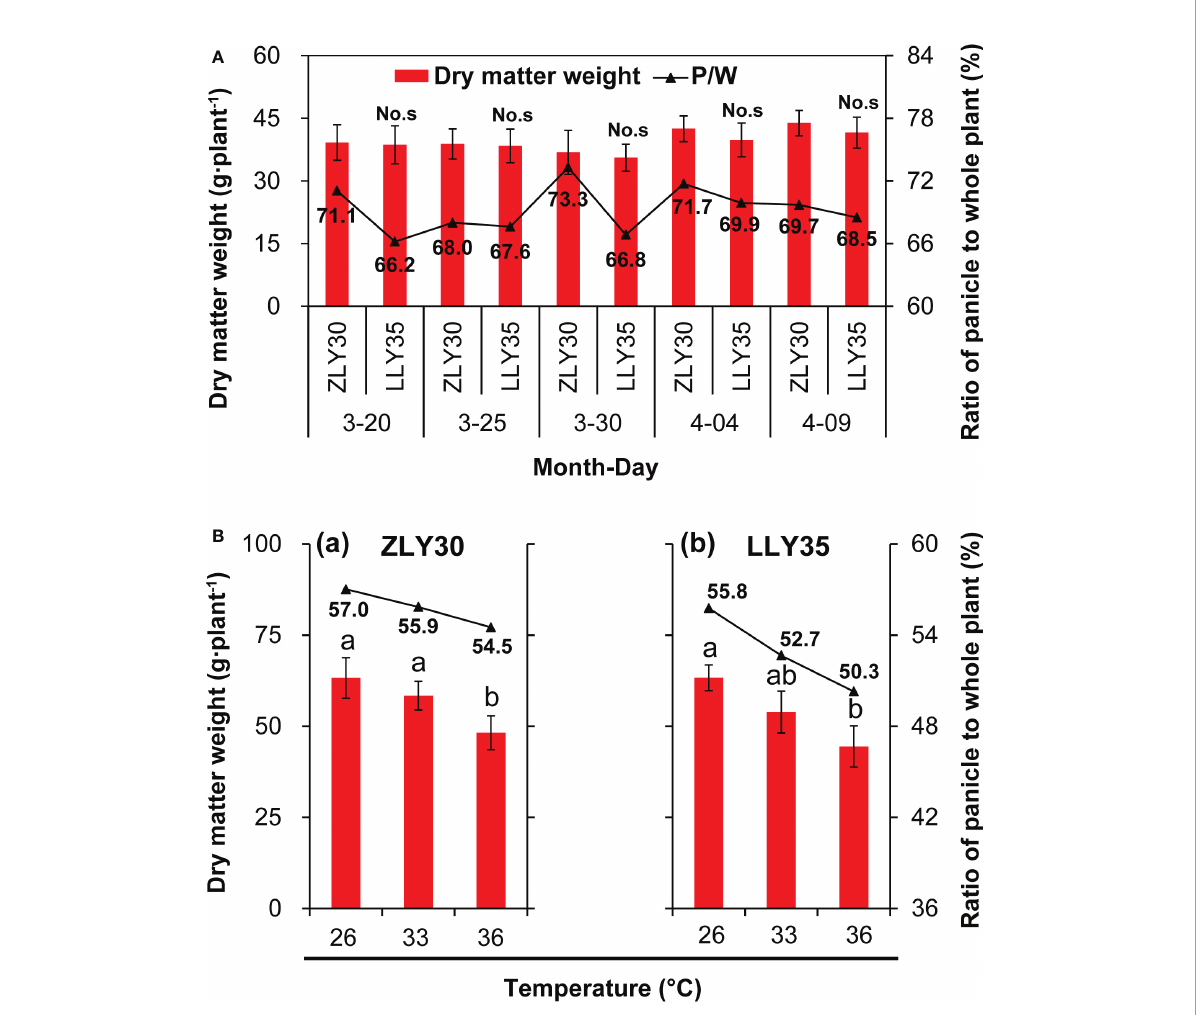
FIGURE 2 Effect of different sowing time and temperatures on the dry matter weight accumulation and allocation of rice. (A) Dry matter weight accumulation and allocation of ZLY30 and LLY35 varied among the sowing times; (B) Changes in dry matter weight accumulation and allocation of two cultivars under different temperatures; Vertical bars denote standard deviations ( n =4). “ No.s ” indicate no signi fi cant difference at the 0.05 probability level between the ZLY30 and LLY35 within one sowing time using T-test analysis. Different letters indicate signi fi cant differences with a least signi fi cant difference test at P ≤ 0.05 among different temperatures within one genotype using one-way analysis of